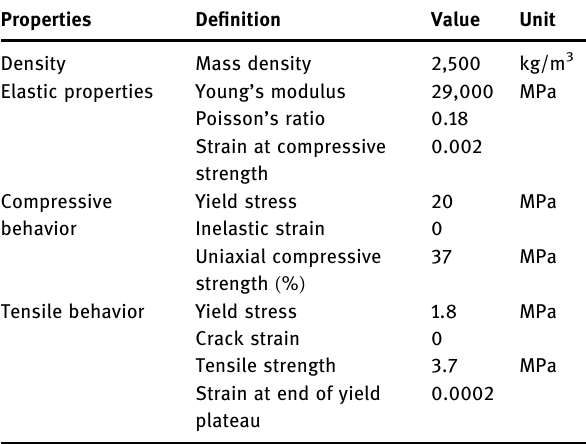
Table 10: Material properties of concrete used in this study Properties